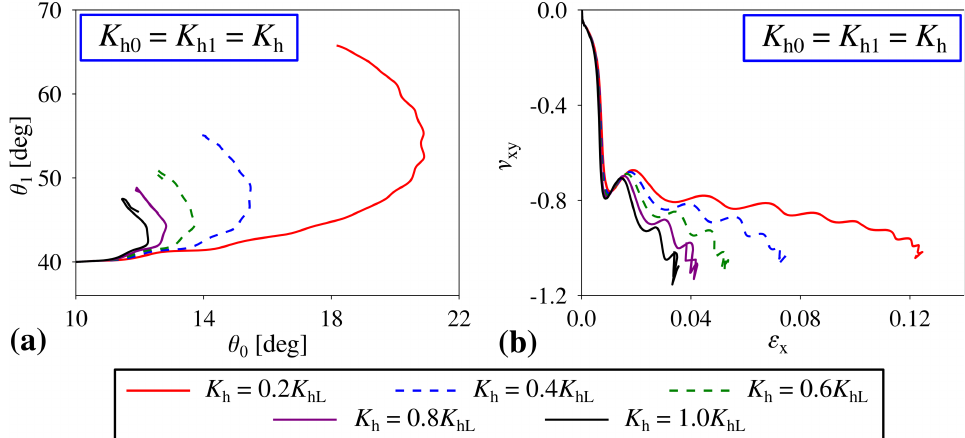
Figure 4. The effect that the variation in the stiffness coefficient related to the hinges has on the behaviour of the structure. ( a ) the dependence of θ 1 vs. θ 0 during the deformation process and ( b ) the variation in the Poisson’s ratio for loading in the x -direction plotted against